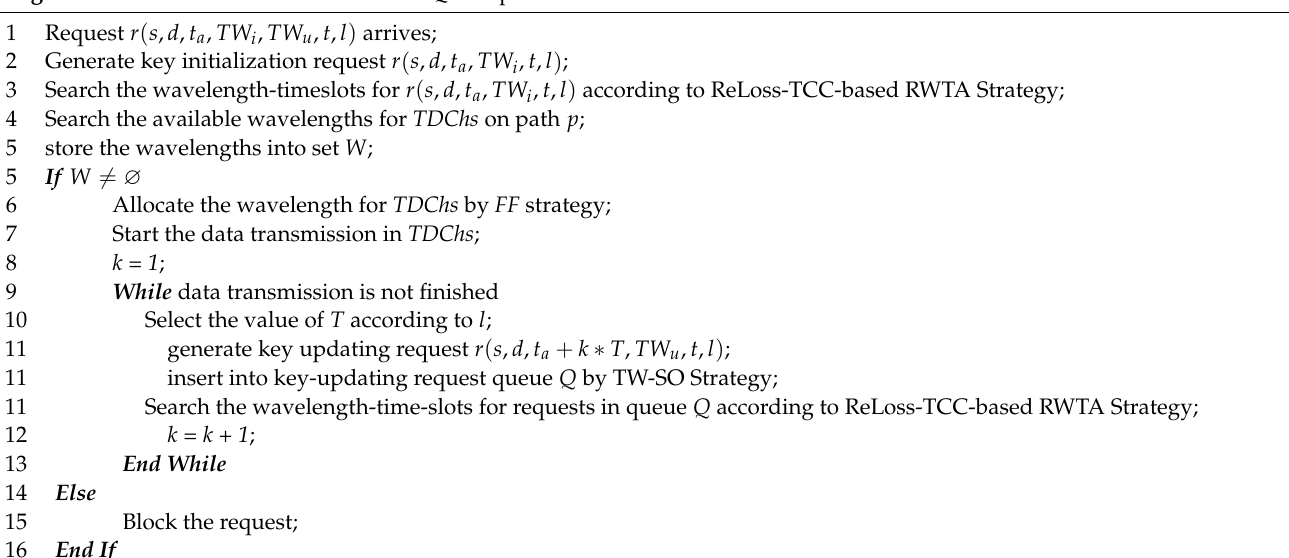
Algorithm 3. Multi-dimensional RWTA in QKD optical